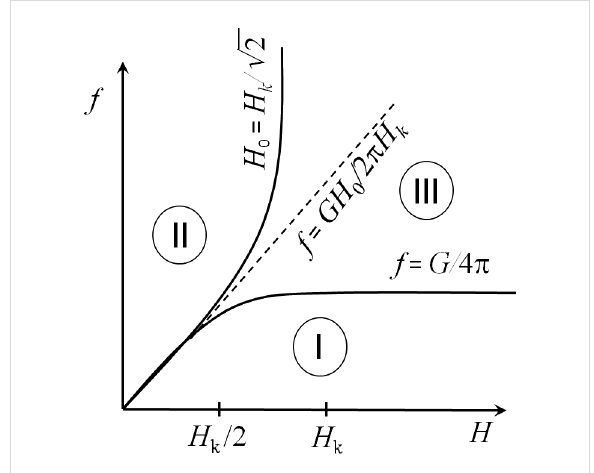
Figure 3: The domains I–III of the different magneto-dynamic modes of nanoparticle motion in a viscous liquid in RMFs obtained analytical- ly based on Equations 9–11 (see Appendix